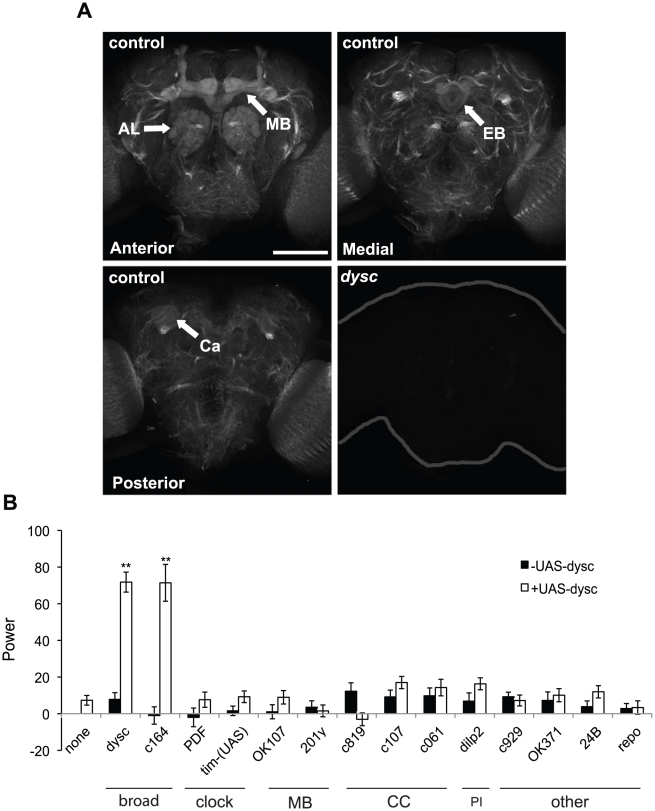
DYSC is enriched in neuronal tracts and is required downstream of the clock cells.(A) Strong DYSC staining was observed in major neuronal tracts throughout the central brain in adult control flies, as well as in the antennal lobes (AL), mushroom bodies (MB) and ellipsoid body (EB). Upper panels show confocal projections spanning the anterior and medial compartments of the adult brain, and lower left panel shows a single 2 µm slice to illustrate DYSC expression in the posterior calyx (Ca) of the mushroom bodies. Similar DYSC immuno-reactivity was not observed in dysc
c03838 homozygous brains (lower right panel), confirming the specificity of the antibody. Scale bar represents 100 µm. (B) Targeted rescue of the dysc circadian phenotype using the UAS-dysc transgene (Isoform G). Data are from homozygous dysc
c03838 or trans-heterozygous dysc
c03838/s168 flies. In addition to dysc mutants carrying a UAS-dysc transgene insertion alone, driver-alone controls were used for each driver line. The power of rhythmicity in DD is shown for each genotype (N≥21, except for pdf-Gal4 driver control, for which N = 17). MB: mushroom bodies; CC: central complex; PI: pars intercerebralis. c929- and OK371-Gal4 lines drive expression in peptidergic and glutamatergic neurons, respectively. 24B- and repo-Gal4 lines are tissue-specific drivers for muscle and glia, respectively. Error bars represent SEM. ** p<0.0001; two-tailed t-test with Bonferroni correction.